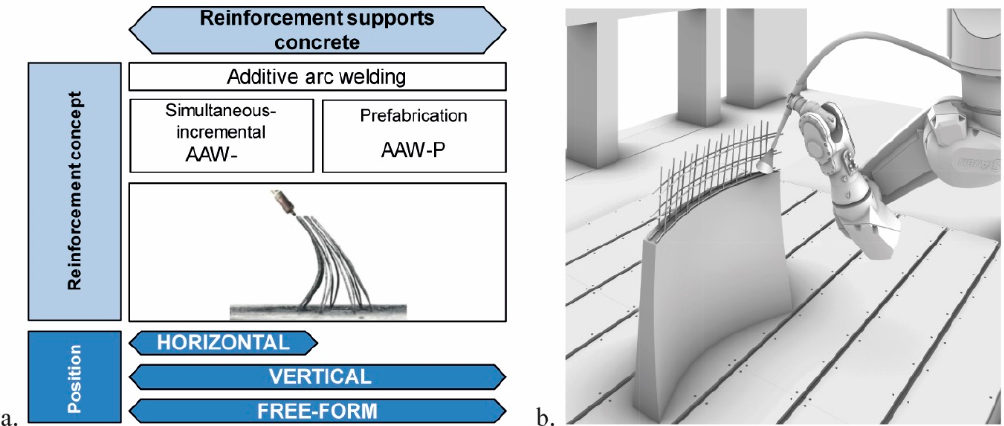
Figure 1. ( a ) Concept of reinforcement supports concrete ( b ) Robotically and automated encasing of prefabricated reinforcement structure by SC3DP. prefabricated reinforcement structure by